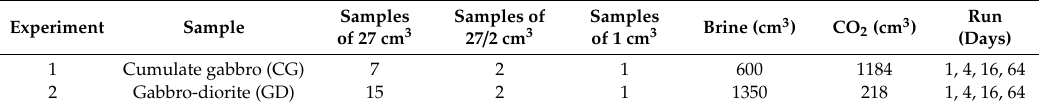
Table 1. Experimental conditions of rock-brine-CO 2 exposure in